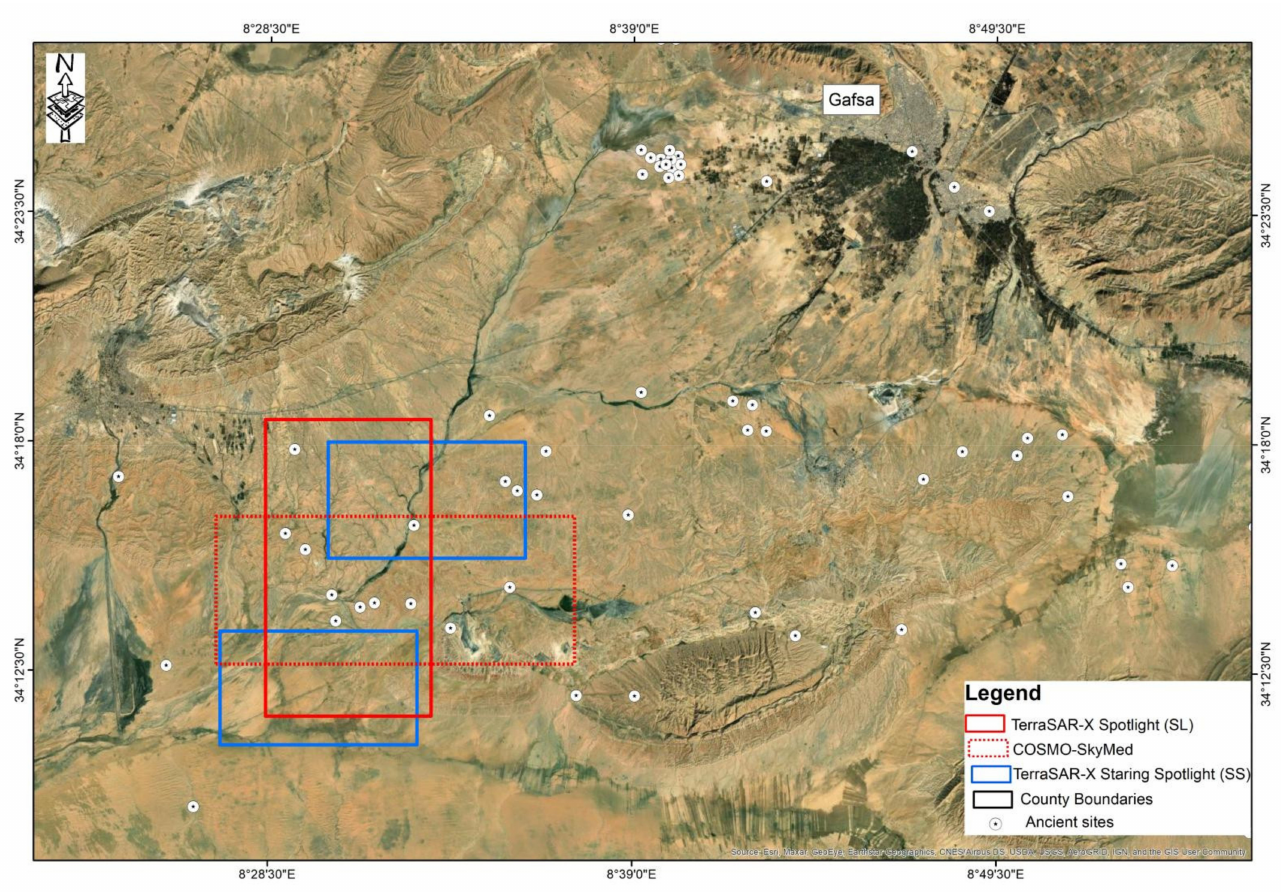
Figure 2. Distribution of the obtained SAR images in the study area: one frame of TSX SL archived time series data (solid red rectangle), one frame of CSK data (dotted red rectangle), and two frames of TSX ST archived time series data (solid blue rectangles).